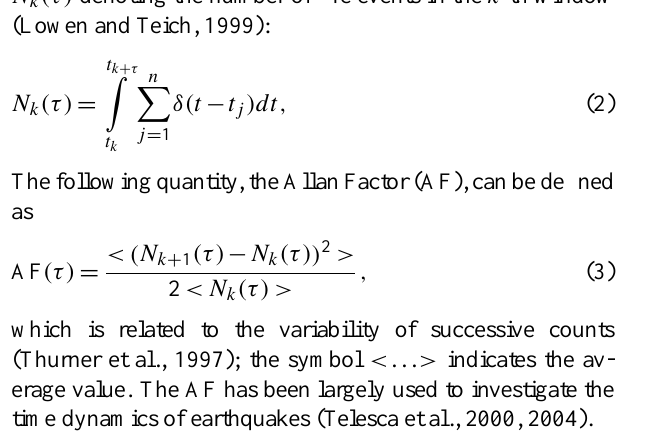
Figure 5. AF for different elevation thresholds.